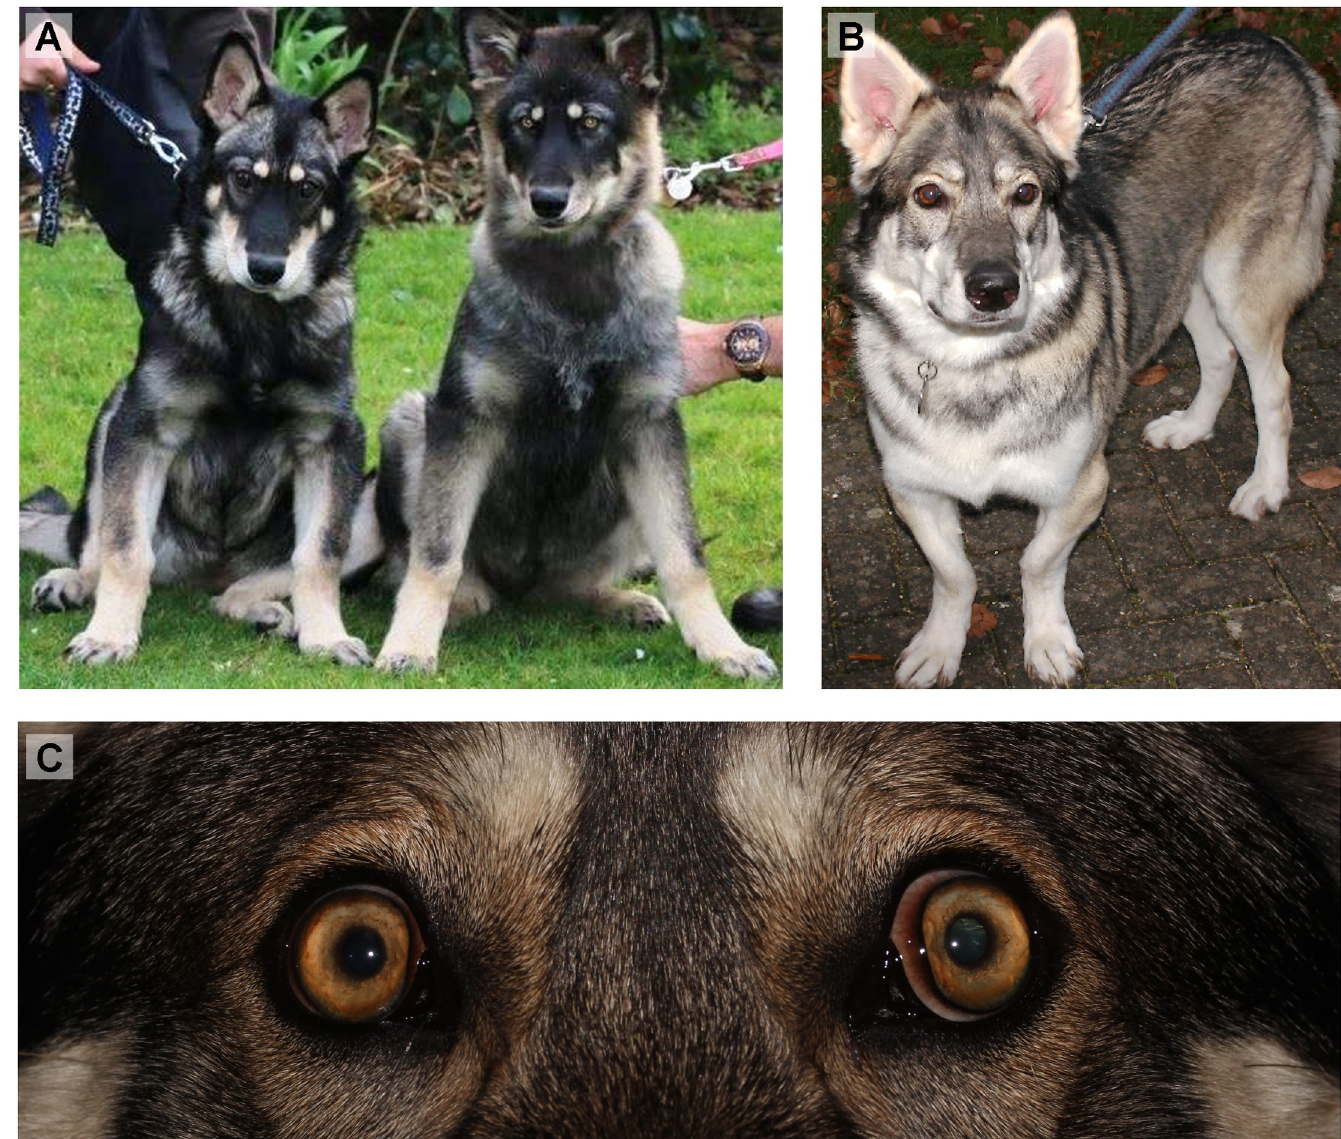
Fig 2. Appearance of oculoskeletal dysplasia (OSD)-affected Northern Inuit Dogs (NID). (A) OSD-affected three month old intact female NID (left, Dog 2) next to an unaffected three month old intact female littermate (right, Dog 11). (B) OSD-affected 3.5 year old neutered female NID (Dog 5). The OSD-affected dogs are shorter in stature, with obvious angular fore limb deformity i.e. varus elbows, valgus and short forelimbs. (C) Affected four month old male also presenting bilateral macroglobus (Dog